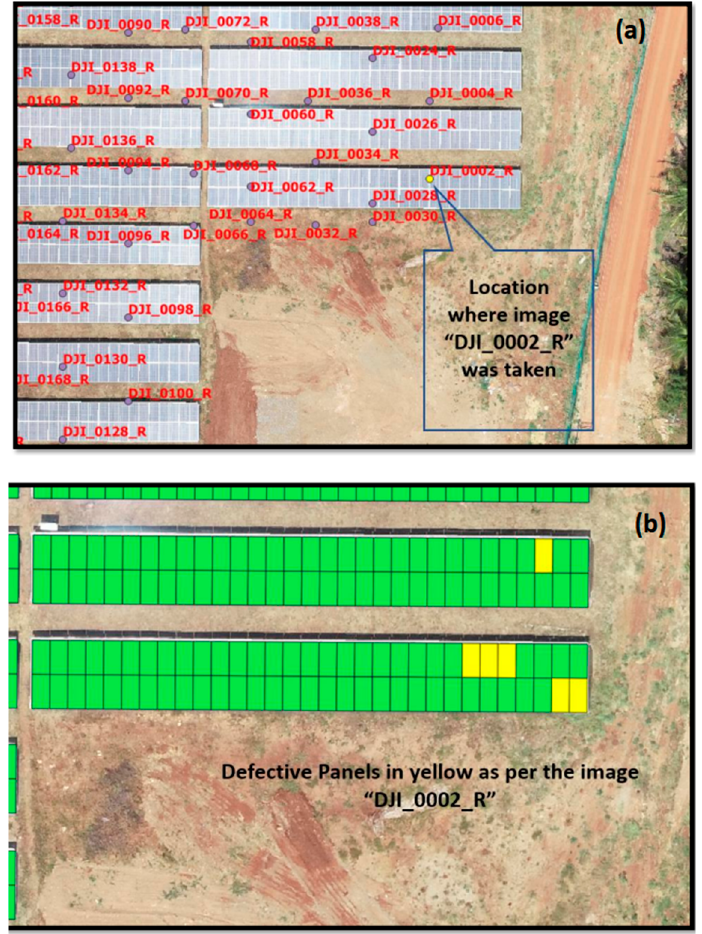
Figure 7. Location of thermal image ( a ) and defective panels in sample thermal image ( b ).